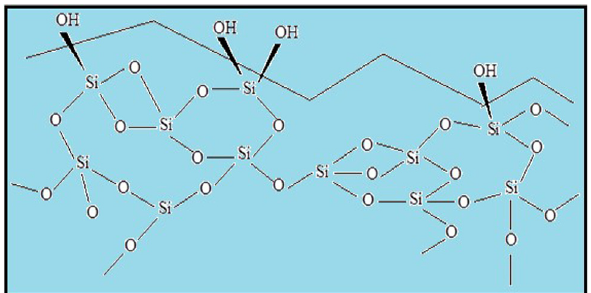
Figure 2: Silica gel chemical